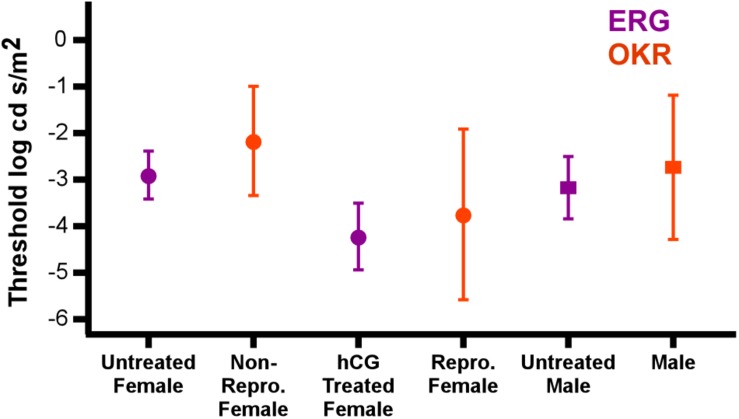
hCG induced modulation of retinal threshold in this study matches change in behavioral threshold in reproductive individuals. Points show comparison of the average (±SD) ERG thresholds with those for optokinetic responses (OKR) under scotopic conditions (Cummings et al., 2008). Data are separated by sex and reproductive state (hCG modulated for ERG; endogenous reproductive state for OKR). Circles and squares are females and males, respectively. ERG responses from this study are in purple, while optokinetic responses from Cummings et al. (2008) are in orange. Note that the stimulus illuminance in the behavioral tests (log Watts/cm2) was converted to log cd s/m2 for this comparison.